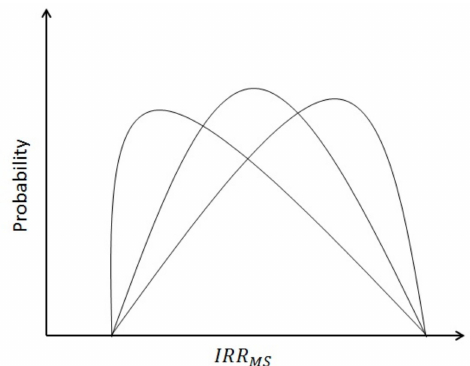
Figure 7. Predicted IRR MS values vs their probability for three hypothetical cases resulting in three di ff erent probability